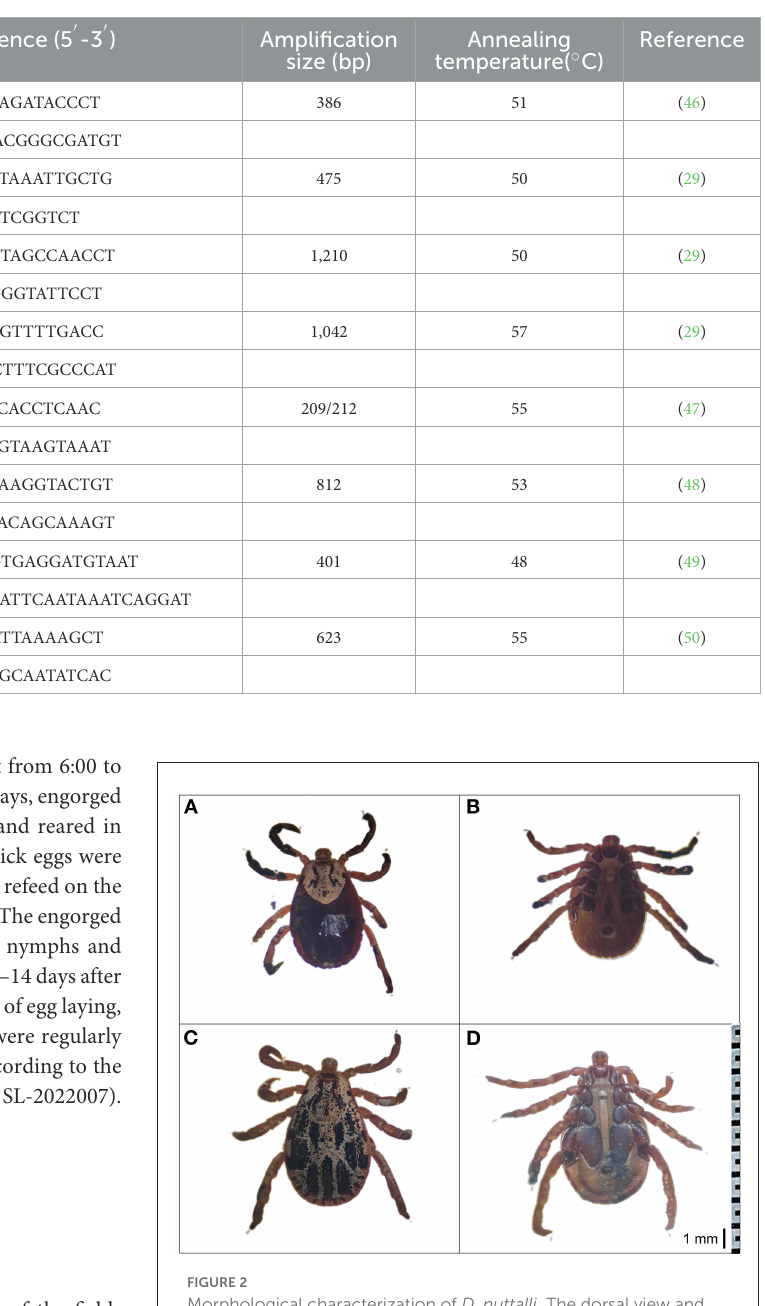
TABLE 1 Oligonucleotide primers used in this study.